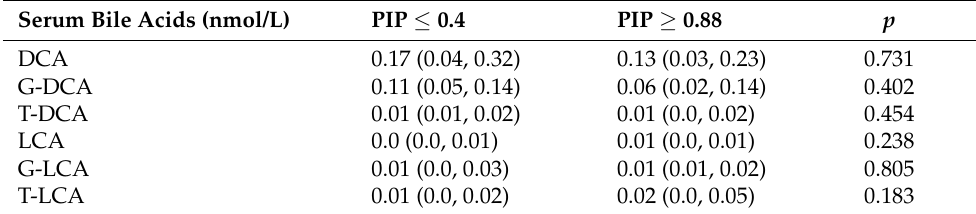
Table 3. Secondary bile acids distribution in different subgroups classified according to their CFTR genotype (median and [Q 1 , Q 3 ]).